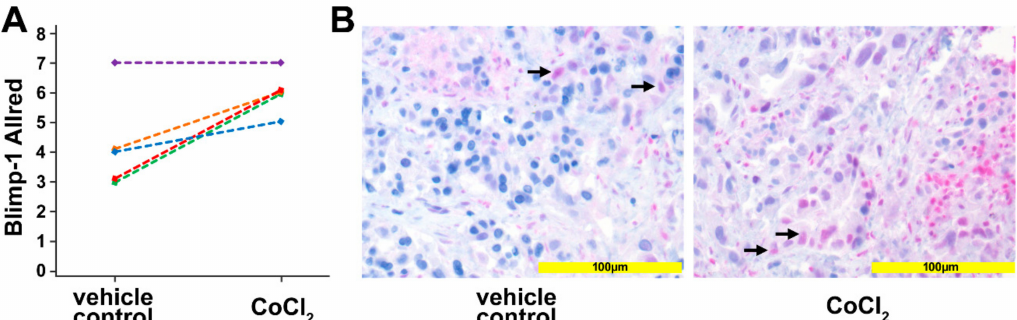
Figure 3. Ex vivo tissue culture. ( A ) Scoring the Blimp-1 immunohistochemical staining of human pancreatic cancer samples treated with 200 µ M CoCl 2 for 24 h. An upregulation of Blimp-1 in the nucleus was detected compared with vehicle-treated controls. Each line represents one slice. ( B ) Left: Vehicle control pancreatic cancer tissue shows scattered and weak nuclear Blimp-1 expression (arrows). Right: Pancreatic cancer tissue treated with CoCl 2 for 24 h shows Blimp-1 expression with wider distribution and moderate staining